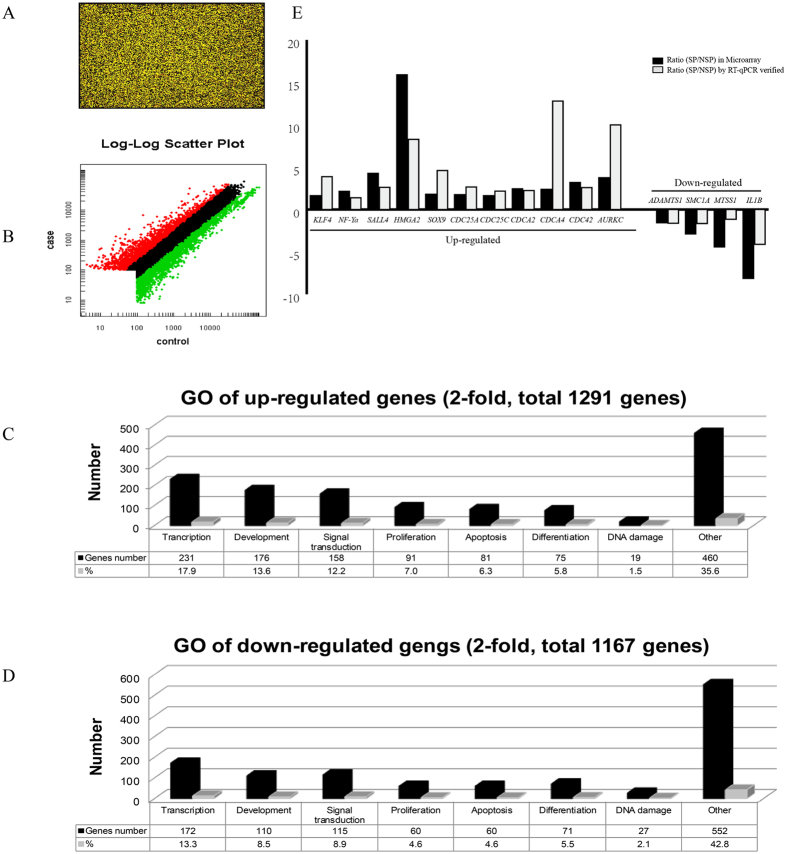
mRNA microarray analysis.(A) Human 8 × 60 k GeneChip image. (B) Scatter Plot SP vs. NSP cells from HepG2 cells. Red and green dots showed the up-regulated (ratio > 2) and down-regulated (ratio < 0.5) genes respectively in SP cells vs. NSP cells. (C) Gene Ontology-GO analysis of up-regulated genes in SP vs. NSP cells, shown were the biology process. (D) Gene Ontology-GO analysis of down-regulated genes in SP vs. NSP cells, shown were the biology process. (E) RT-qPCR assay validation of the differential expression of some genes. The microarray assay was performed on SP and NSP cells isolated form HepG2 cells, considering the rather huge individual differences in fresh HCC tissue samples.